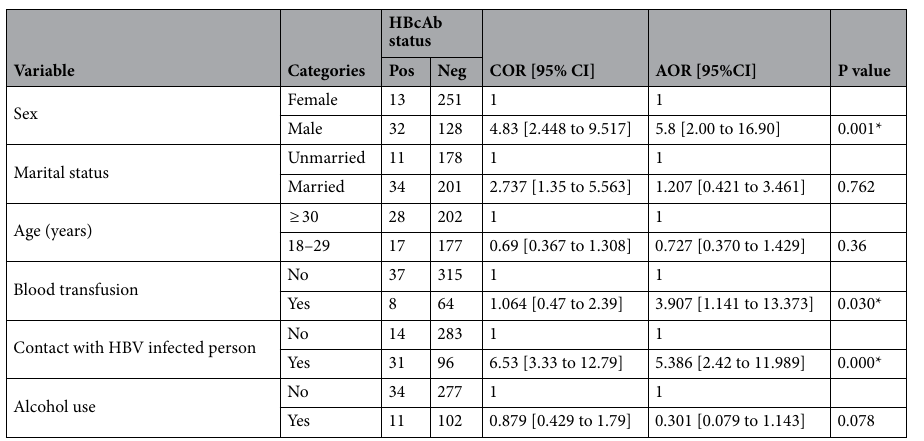
Table 5. Socio-demographic factors associated with HBcAb serostatus among HBsAg seronegative hospital attendees screened for HBV before